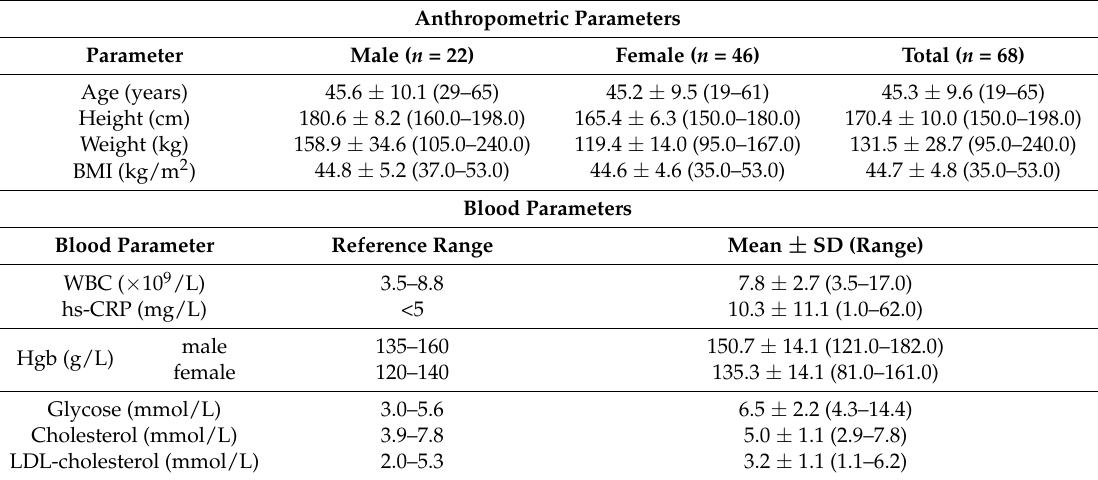
Table 1. Clinical data of study subjects (mean ± SD,